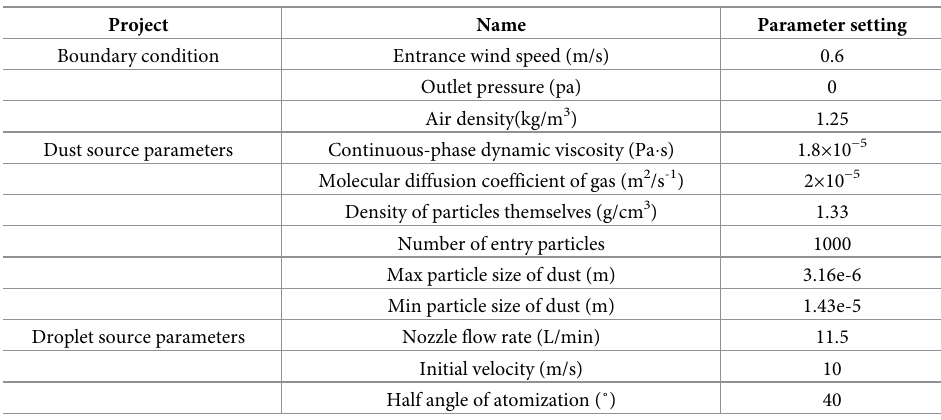
Table 5. Boundary conditions and parameter